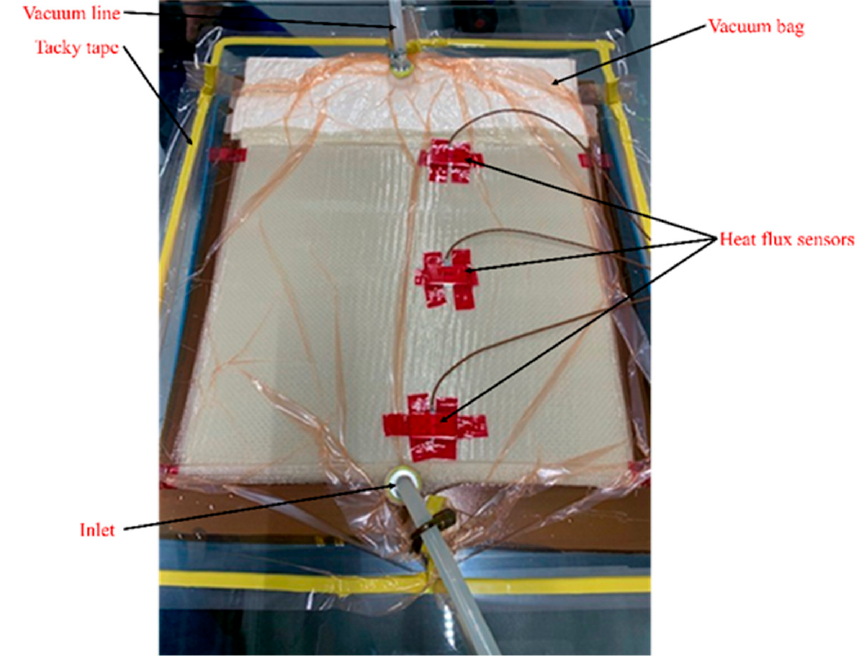
Figure 3. The position of heat flux sensors during vacuum infusion.